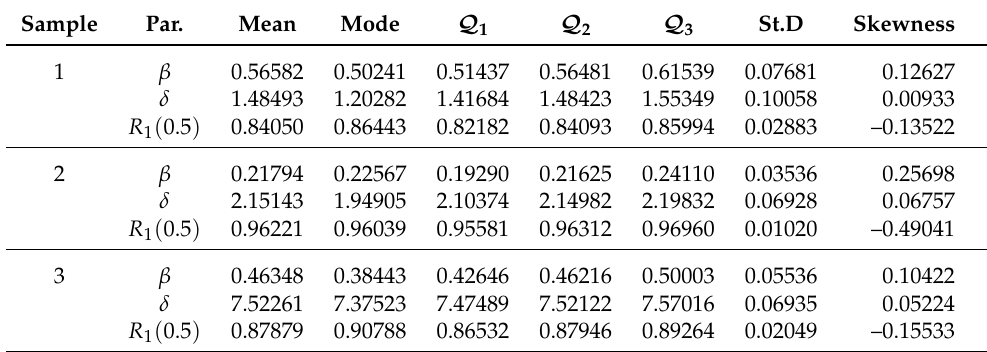
Table 6. Characteristics of β , δ and R 1 ( t ) from insulating fluid data.